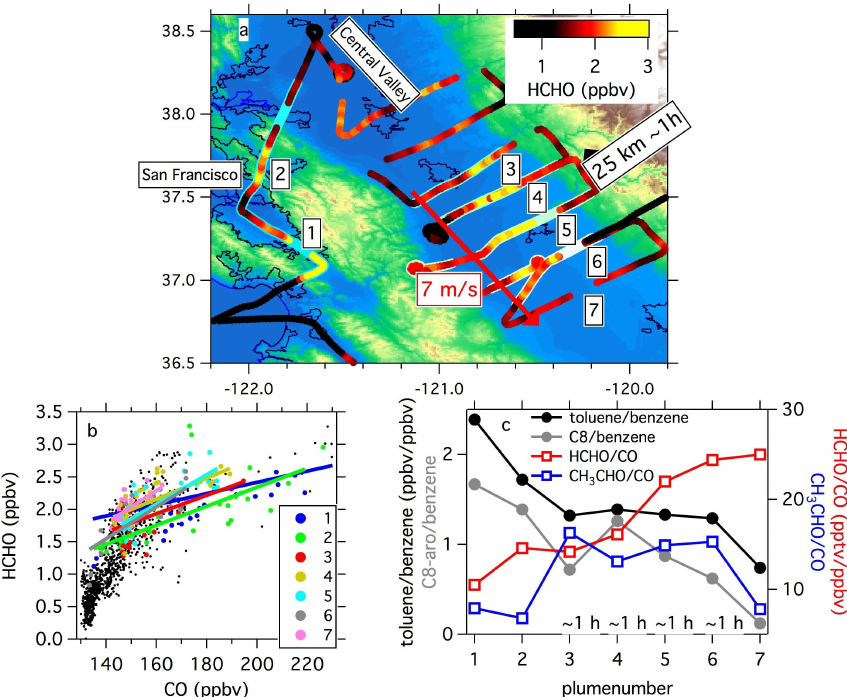
Fig. 10. (a) A map of the Central Valley with the flight track of the NOAA WP-3, which has been color coded by the HCHO mixing ratio. (b) Scatter plot of HCHO versus CO with individual plume crossings indicated in different colors. The linear fits for the individual plume crossings are also shown. (c) The increase of the HCHO/CO and CH 3 CHO/CO ratios – slopes of the linear fits in (b) – together with the simultaneous decrease in toluene/benzene and C8-aromatics/benzene ratios during the processing of the anthropogenic plume travelling down the Central